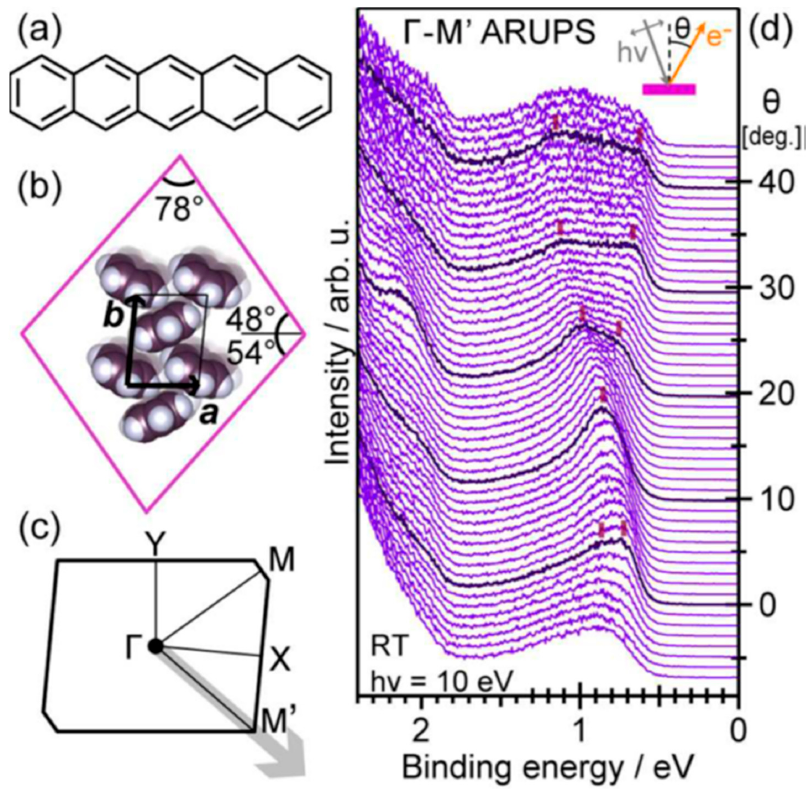
Figure 8. ( a ) Molecular structure of pentacene. ( b ) Schematic illustration of the molecular arrangement and unit cell of the pentacene (001) surface with the typical parallelogram-shape. ( c ) Surface Brillouin zone of pentacene single crystal. The direction of the ARPES measurements is indicated by the gray arrow. ( d ) ARPES spectra of pentacene single crystal taken toward the Γ− M ′ direction at RT. The vertical bars are guides for the eyes to indicate the peak positions of spectral components. The measurement geometry is illustrated in the inset. From Ref. [85] with permission.